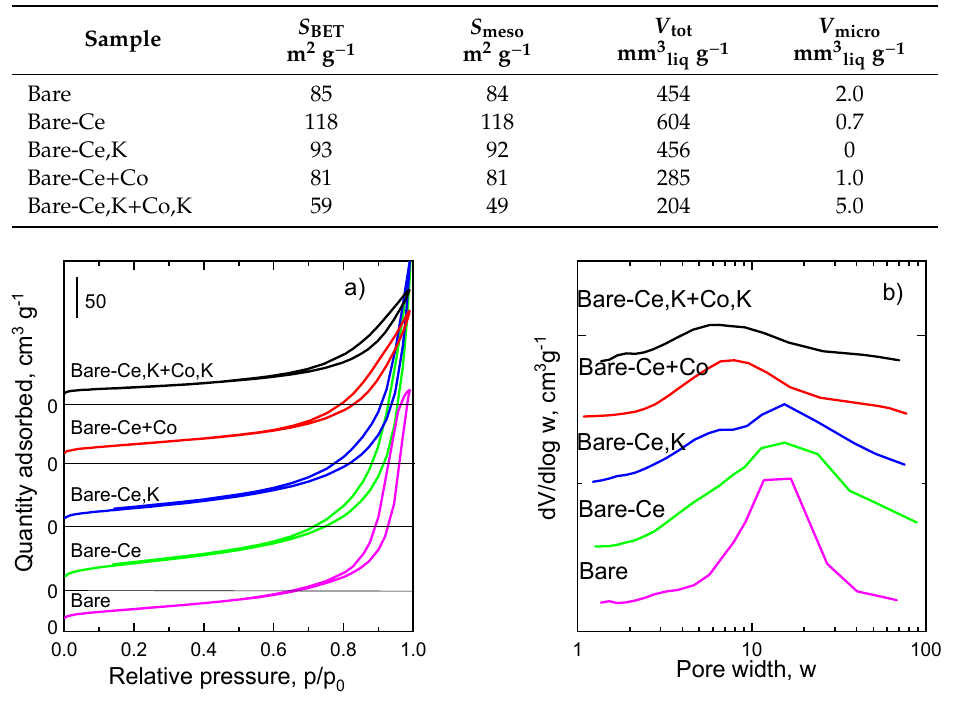
Figure 2. ( a ) N 2 adsorption–desorption isotherms at − 196 °C of the examined catalysts and ( b ) their pore size distributions evaluated from nitrogen physical adsorption. Table 2. Characteristic values of catalysts’ pore size distributions.